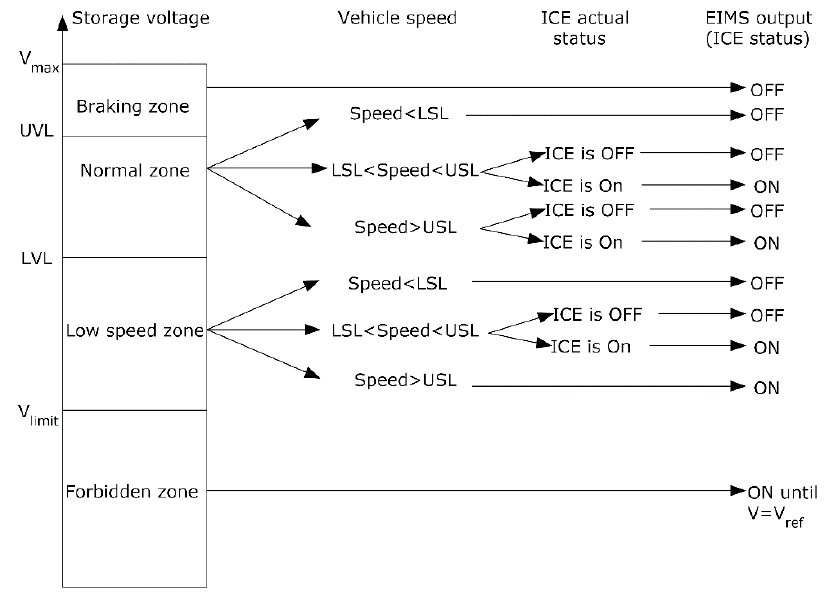
Figure 2. Engine Ignition Management System (EIMS).